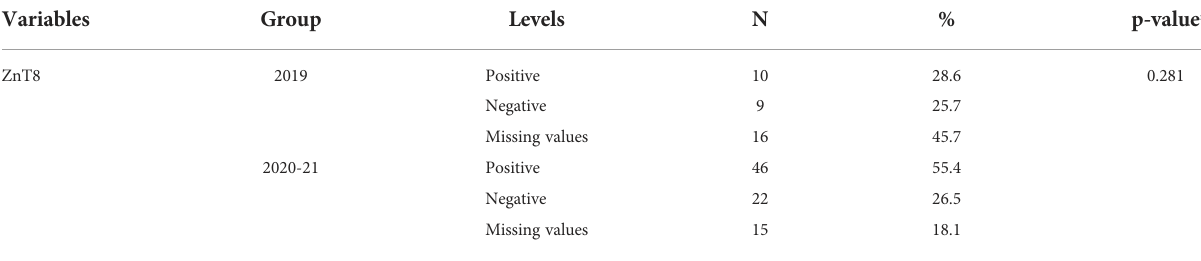
TABLE 2 Demographic and clinical characteristics of the sample: quantitative variables ( Ν = 118). Variable